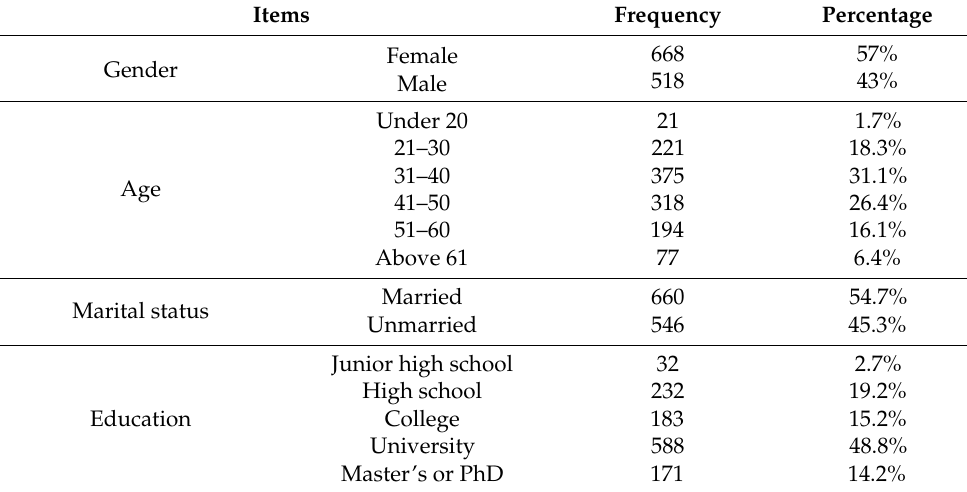
Table 3. The features of the respondents in the